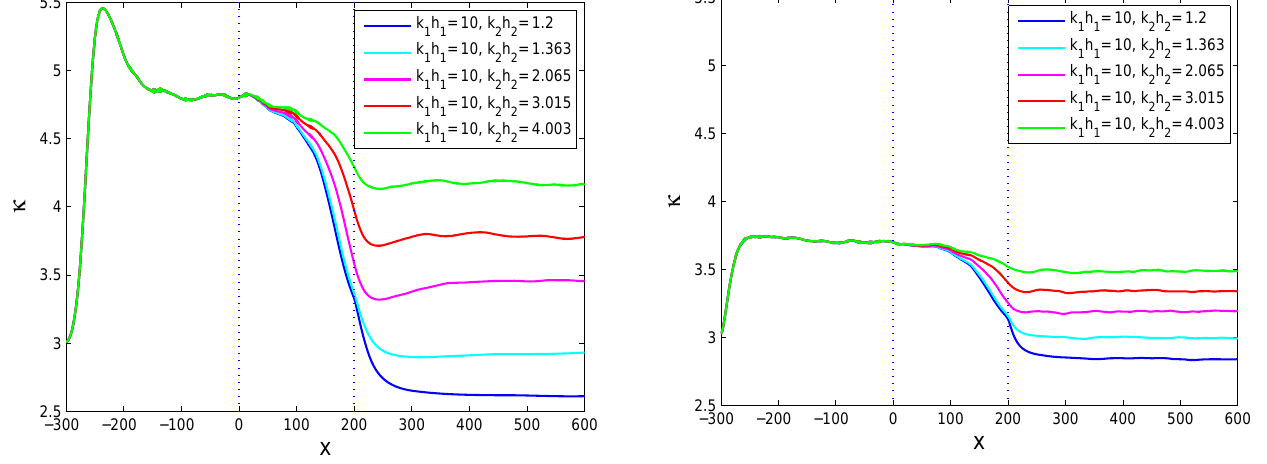
Fig. 8. Kurtosis as a function of x for k 1 h 1 = 10, k 2 h 2 = 1.2, 1.363, 2.065, 3.015, 4.003 and initial BFI = 1 . 0.